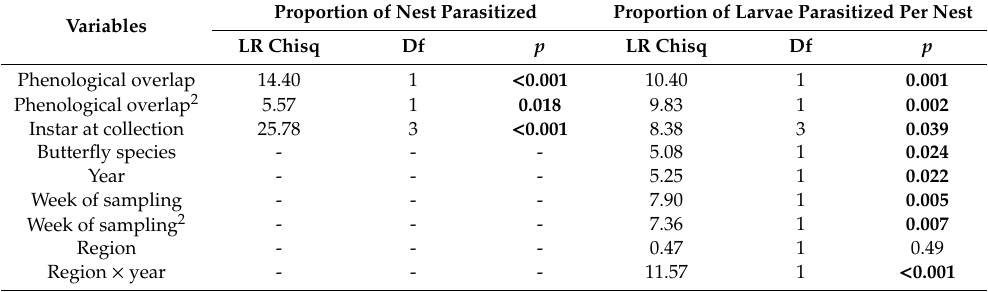
Table 3. Type II ANOVA table showing variation in parasitism rate according to the butterfly host ( A. urticae and A.io ), region, phenological overlap, sampling week, larval instar at collection, the quadratic term for the sampling week (week of sampling 2 ) and the phenological overlap (phenological overlap 2 ), and the two-way interactions between the butterfly host and region, phenological overlap, and larval instar at collection. Significance above 0.05 indicated in bold. Proportion of Nest Parasitized Proportion of Larvae Parasitized Per Nest Variables LR